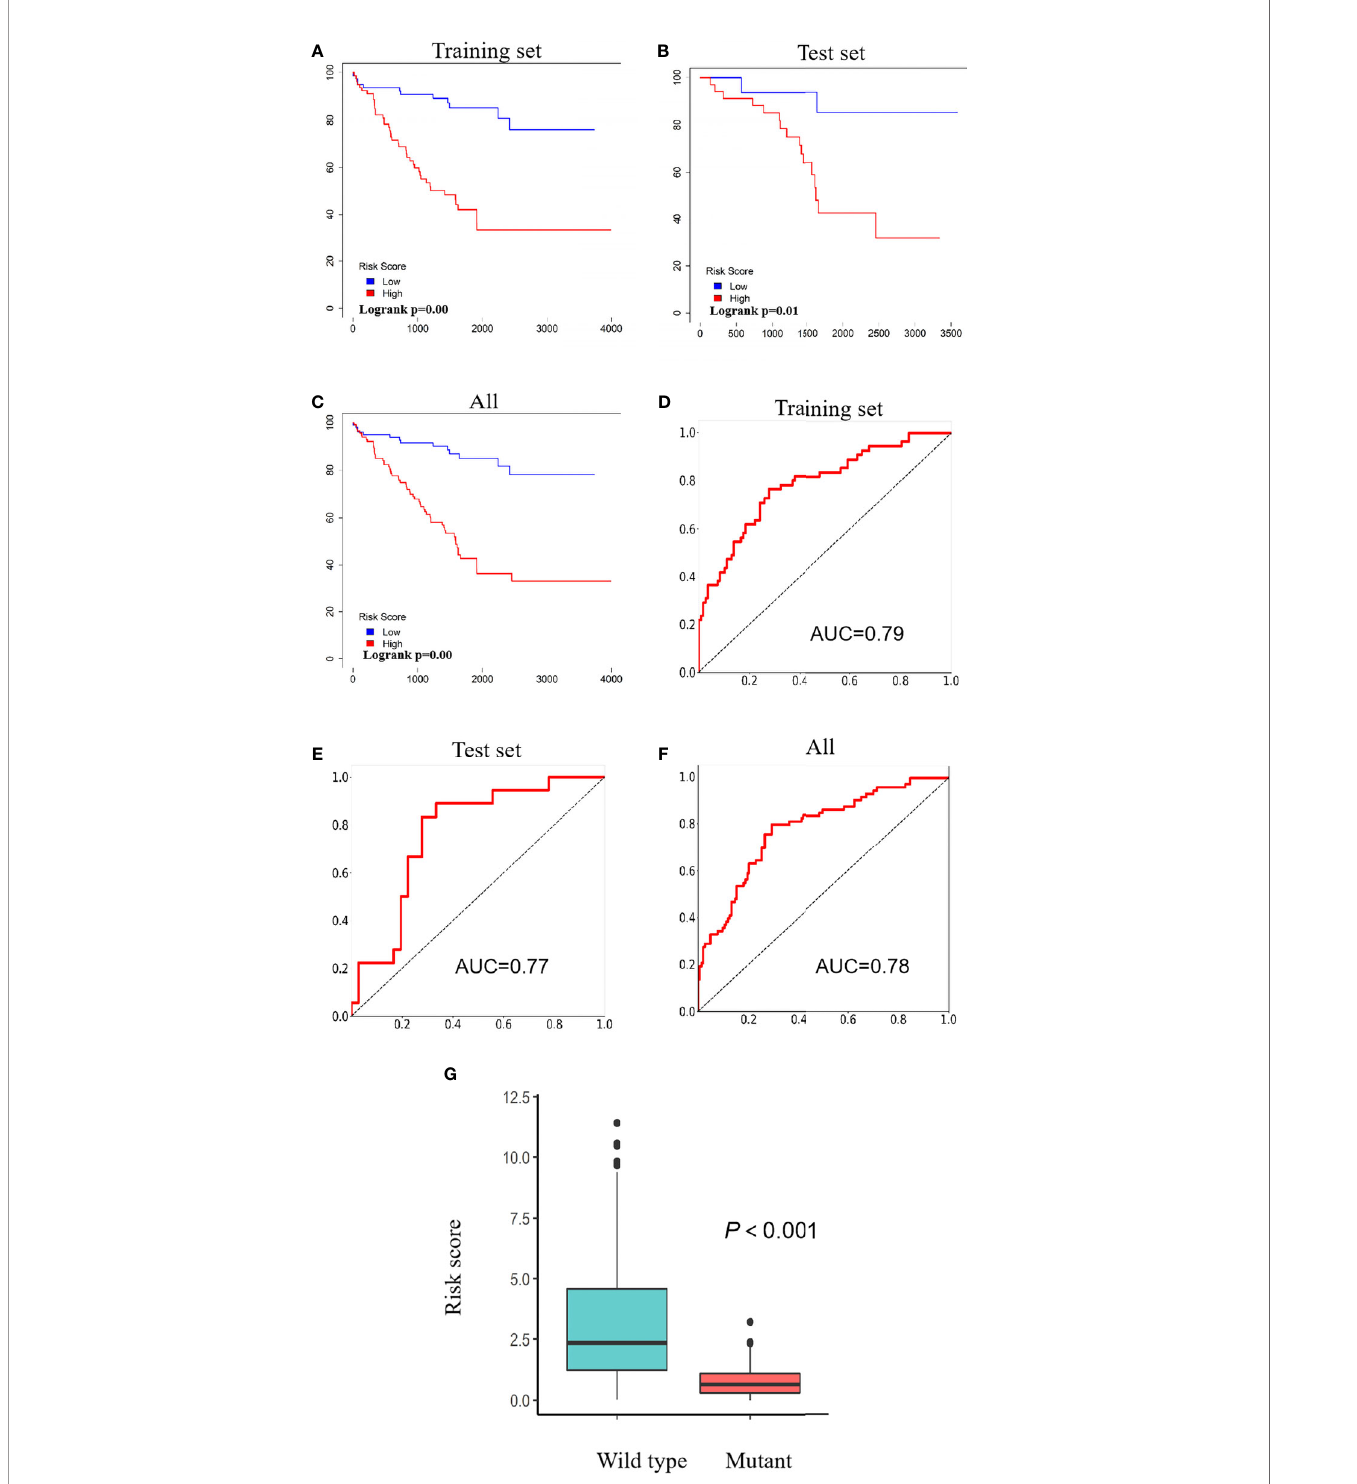
FIGURE 6 | Risk scores predict patients ’ survival. (A – C) Kaplan – Meier curves showing the relationship between risk scores and patients ’ survival in the training set (A) , test set (B) , and all patients (C) . (D – F) ROC curves showing AUC values of the training set (D) , test set (E) , and all patients (F) . (G) A scatter diagram showing differences of risk scores between patients carrying wild type and those carrying mutant VHL. ROC, receiver operating characteristic; AUC, area under the curve; VHL, Von Hippel –